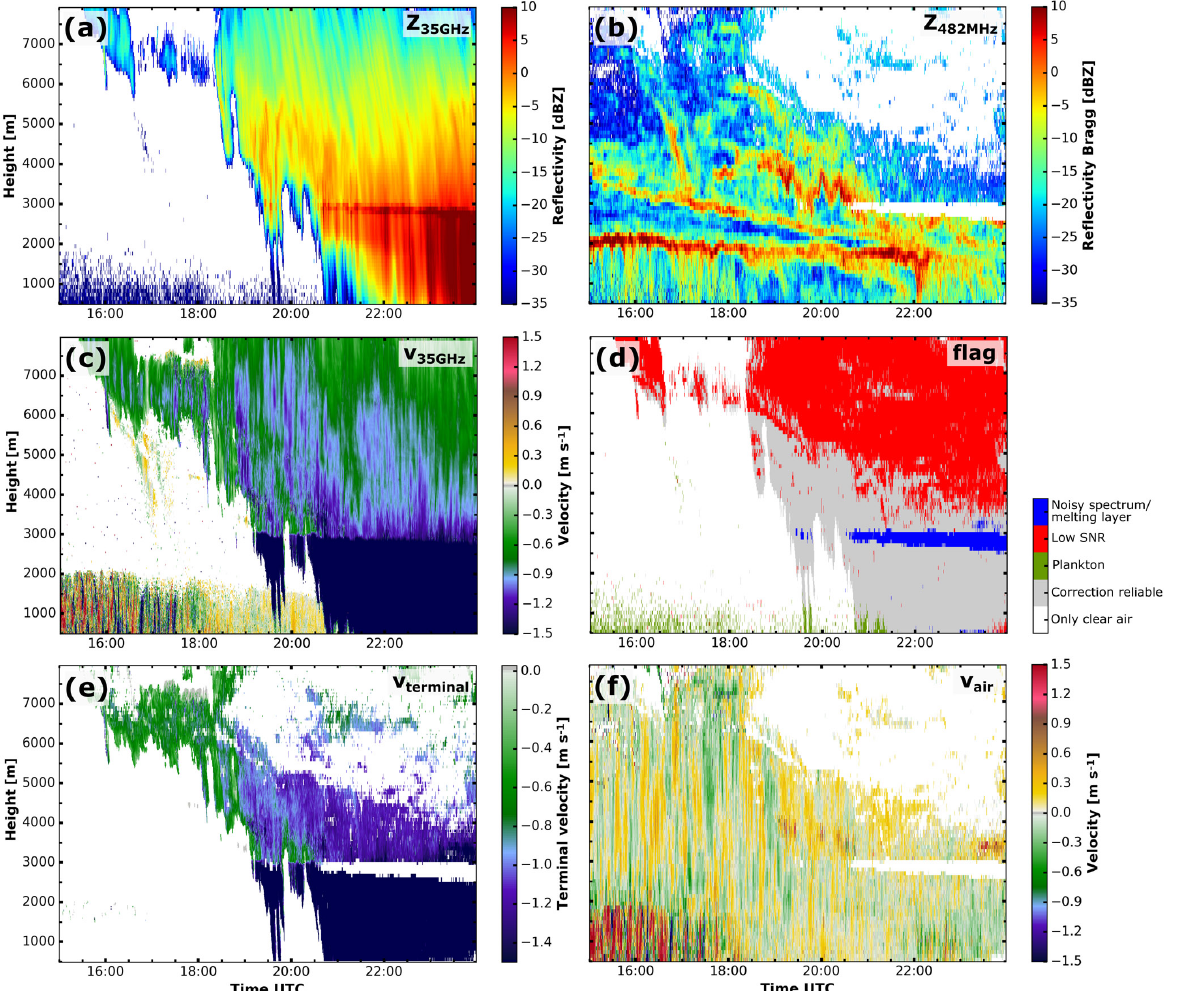
Figure 8. Measurements and value added products during the evening of 17 June 2015. Cloud radar reflectivity (a) and vertical velocity (c) . RWP reflectivity (b) , quality flag (d) and retrieved vertical air motion (f) . The particle terminal velocity calculated from the air velocity and the cloud radar velocity (e) . For the impact of the separation algorithm compare (a) and (f) to Fig. 3. Areas flagged for quality reasons are coloured